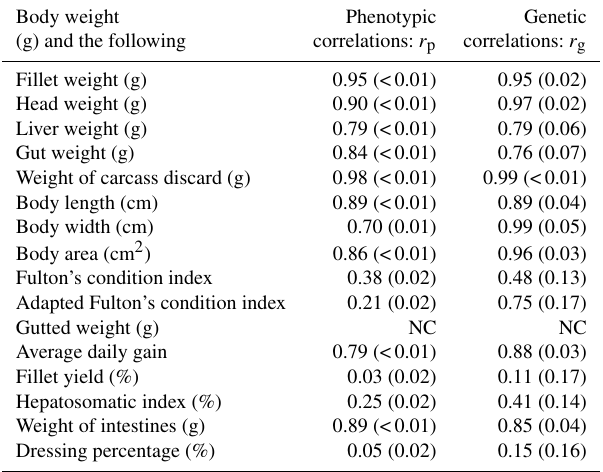
Table 4. Estimates of phenotypic ( r p ) and genetic ( r g ) correla- tions for body weight at slaughter (BW) and other traits. BW: body weight at slaughter (g); L: body length (cm); W: body width (cm); A: body area (cm 2 ); FW: fillet weight (g), FY%: fillet yield